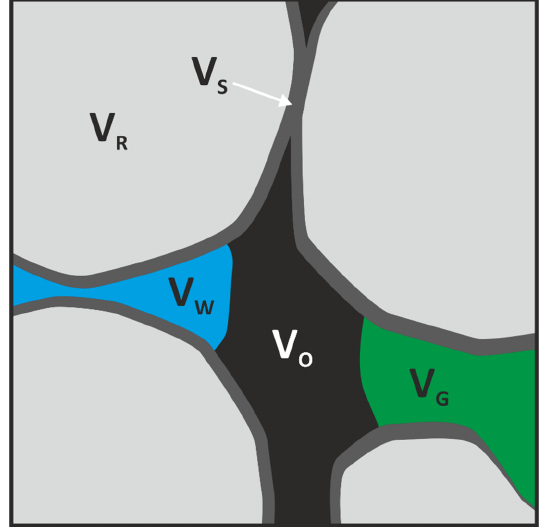
Figure 8. Grain scale diagram to show how the modelling software quantifies bulk volume (V B ), rock volume (V R ), fluid volume (V F ), residual coat (V S ), gas (V G ), water (V W ) and void volume (V V ) for use in the equations.